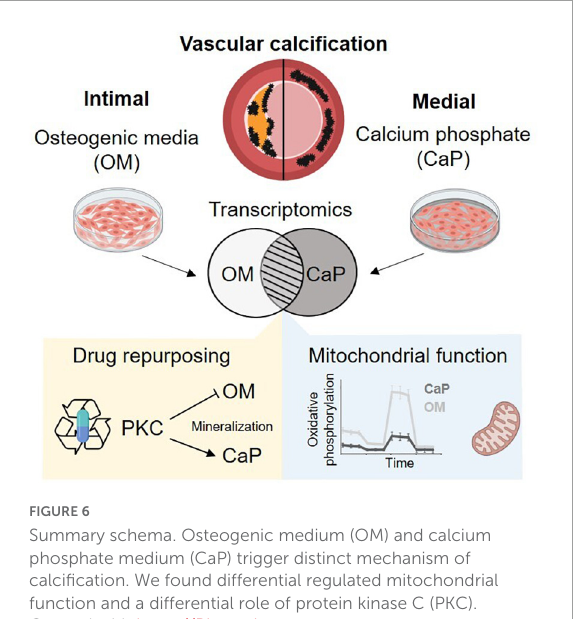
FIGURE6 Summary schema. Osteogenic medium (OM) and calcium phosphate medium (CaP) trigger distinct mechanism of calcification. We found differential regulated mitochondrial function and a differential role of protein kinase C (PKC). Created with